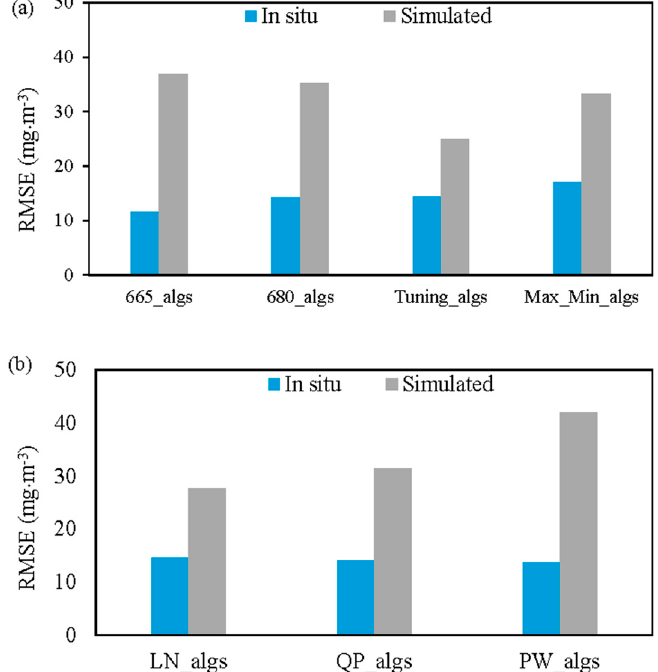
Figure 11. Comparison of the average retrieval accuracy of the in-situ and simulated datasets in terms of RMSE: ( a ) 665_algs, 680_algs, tuning_algs, and Max_Min_algs denote the average retrieval for all the algorithms that included the 665-nm band, 680-nm band, band tuning and maximum and minimum, respectively; and ( b ) LN_algs, QP_algs, and PW_algs represent the average of all the algorithms with linear, quadratic polynomial, and power regression models, respectively.